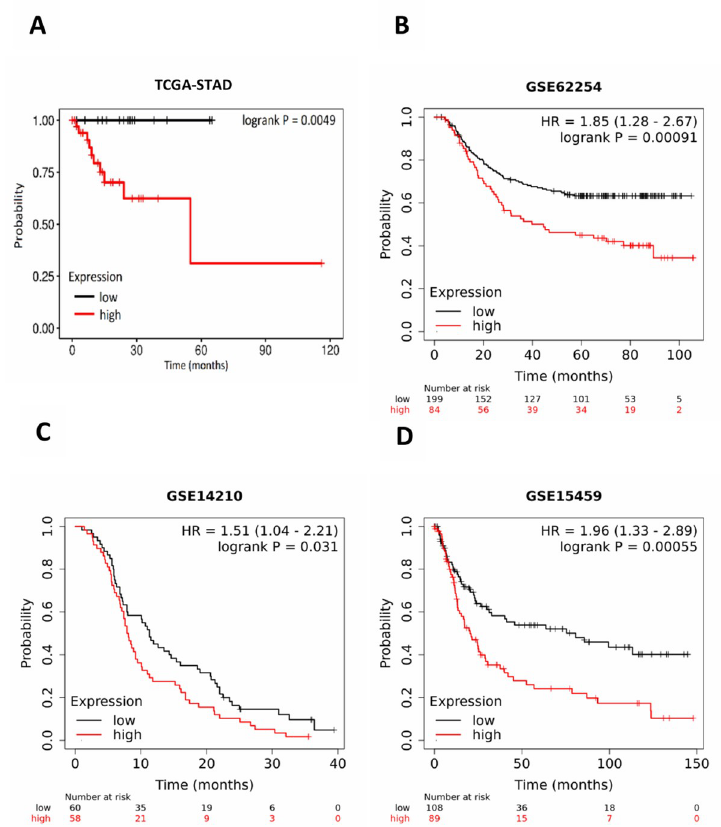
Fig 2. Kaplan-Meier plots of the survival analysis of GC patient data: Kaplan-Meier plots of the survival analysis of GC patient data from the TCGA RNA sequencing datasets (A) and three publicly available Gene Expression Omnibus (GEO) datasets, namely, (B) GSE62254 ACRG (Asian Cancer Research Group, N = 300) gastric cohort, (C) GSE14210 (metastatic gastric cancer patients, N = 145) and (D) GSE15459 (primary gastric tumors from Singapore patient cohort, N = 200) The patients are stratified in two groups (high expression in red and low expression in black) according to the expression profiles of ASPN. P-values for the significance of the difference between high and low expression were calculated using the log-rank